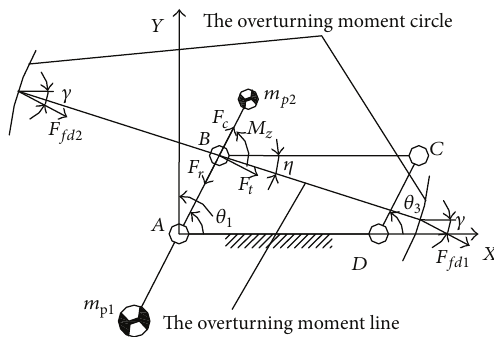
Figure 3: Schematic diagram of external